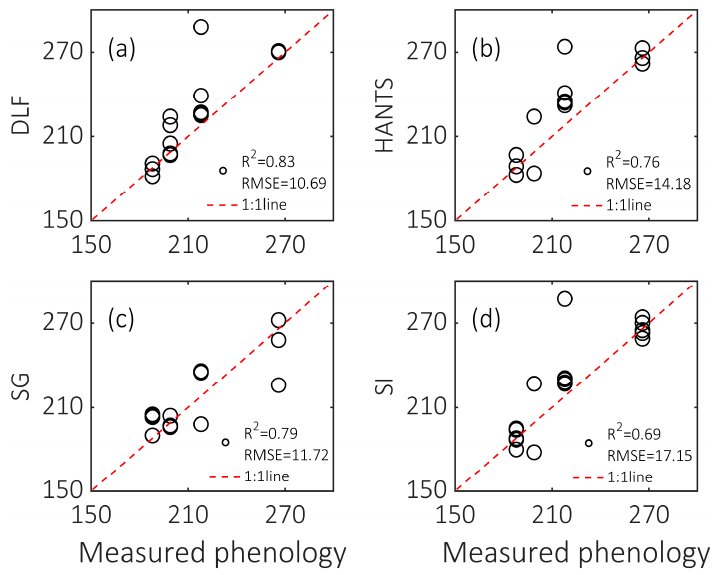
Figure A4. Comparison of extracted and observed phenology from ground observations of maize using different filtering methods at the site in Nanpi in 2020. Note: ( a – d ) represented the comparison of extracted phenology using DLF, HANTS, SG, and SI, respectively. Table A1. Comparison of phenological extraction with previous studies.